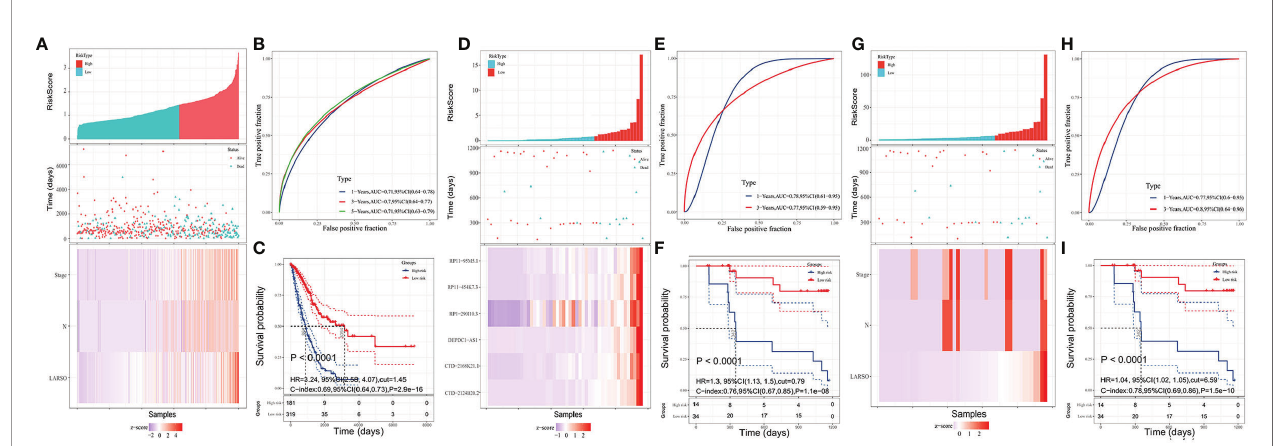
FIGURE 4 | LARSO combined with stages and N stages for predicting the prognosis of LUAD patients. (A) Risk grouping situation, the scatter diagram of patient survival status, and the distribution of LARSO, stage, and N stage in each sample are shown. (B) The 1-, 3-, and 5-year ROC curves plotted based on NRS and patient survival. (C) Kaplan – Meier analysis: the overall survival time of patients in the high-risk group was signi fi cantly shorter than that in the low-risk group ( P < 0.0001). (D) The LARSO values were calculated based on the survival state of 48 patients and the expression of the six lncRNAs. Histogram of the high- and low-risk distribution, scatter plot of patient survival, and the heat map of the expression of the six lncRNAs were displayed. (E) The 1- and 3-year ROC curves were drawn based on the LARSO value and the survival state of patients. (F) Kaplan – Meier analysis: the overall survival time of patients in the high-risk group was signi fi cantly shorter than that in the low-risk group ( P < 0.0001). (G) The risk grouping, the scatter diagram of patient survival status, and the distribution of LARSO, stage, and N stage in each sample were shown after NRS was calculated. (H) According to the 1- and 3-year ROC curves drawn based on the NRS value and patient survival time, the AUC value of 1-year ROC was 0.77, while the AUC value of the 3-year ROC was up to 0.8. (I) Kaplan – Meier analysis: the overall survival time of patients in the high-risk group was signi fi cantly shorter than that in the low-risk group ( P < 0.0001). A log-rank test was used for survival